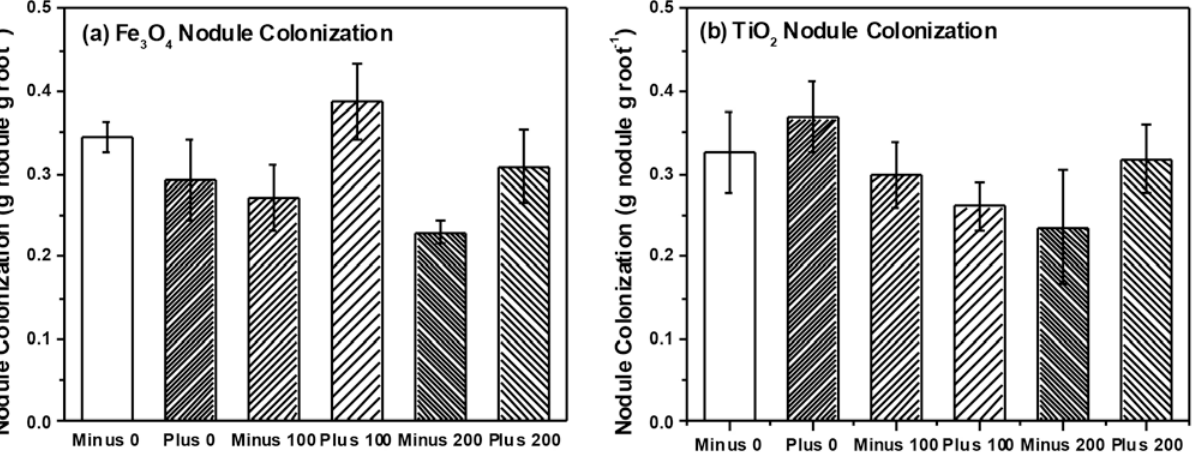
Figure 5. AM colonization in soybean plants treated with ( a ) Fe 3 O 4 and ( b ) TiO 2 NPs, respectively.